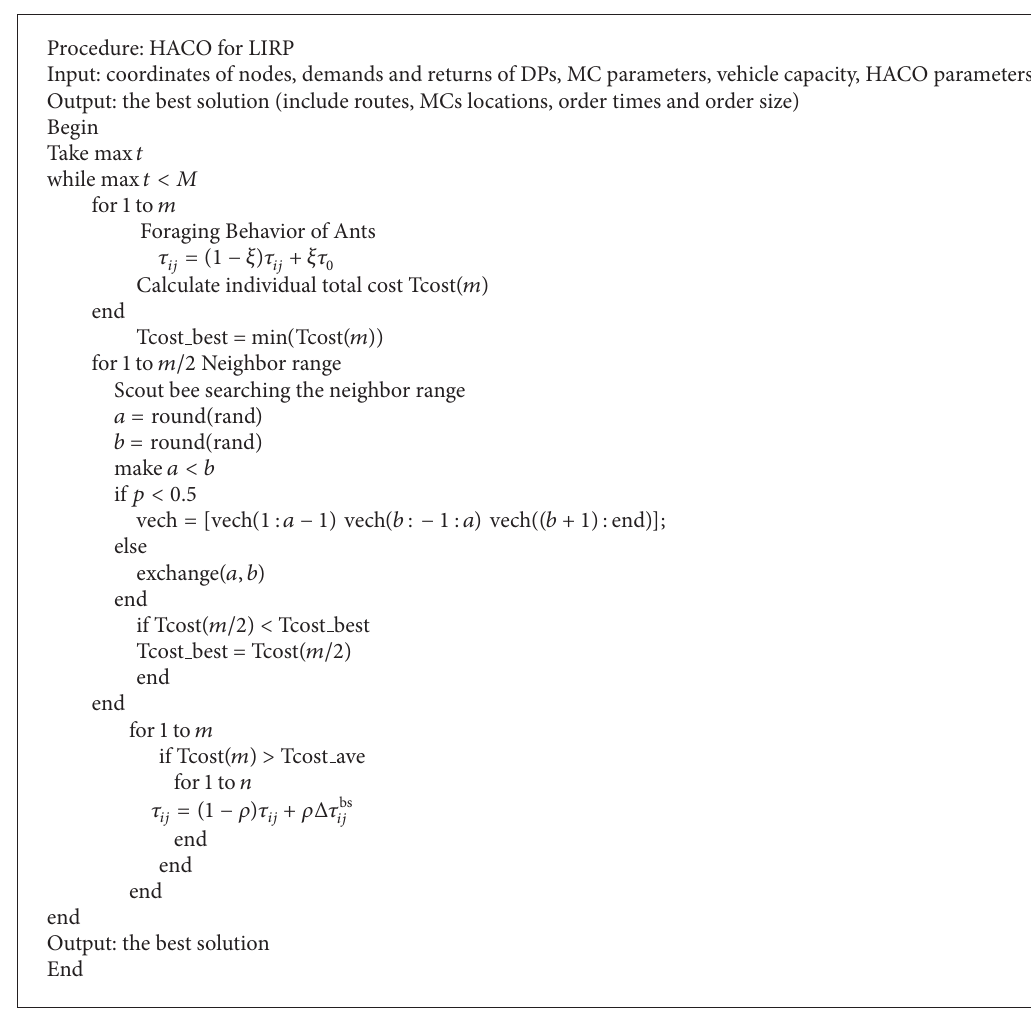
Pseudocode 2: Pseudocode of the proposed